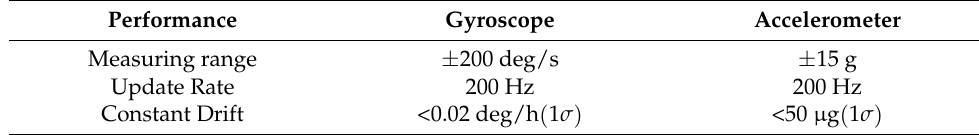
Table 4. The performance of IMU. Table 5 The performance of DVL.